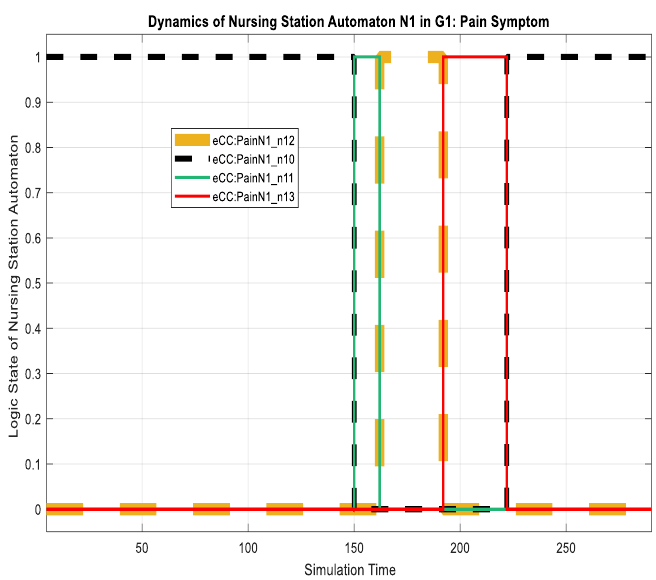
Figure 19. Dynamics of the nursing station, N 1 , in terms of monitoring the pain symptom.